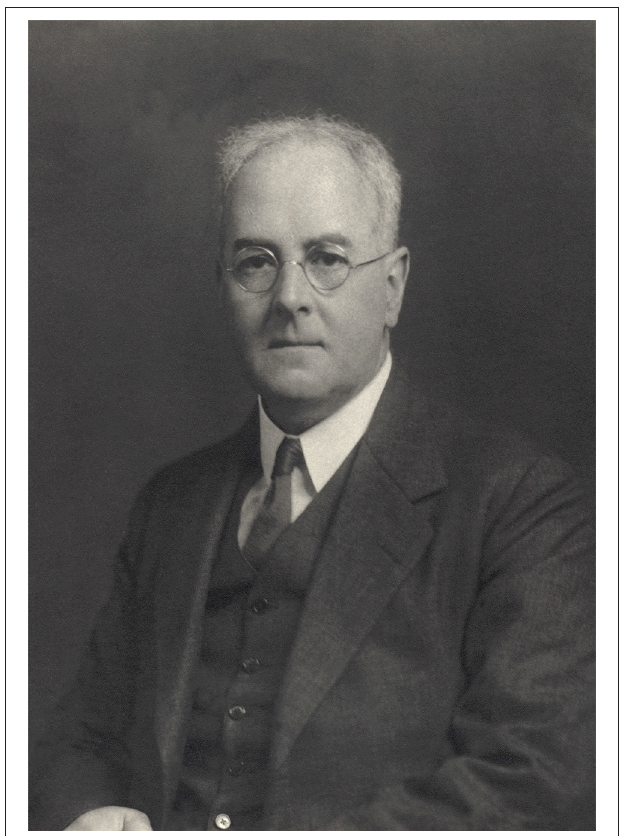
FIGURE 1 | Lewis Fry Richardson (1881–1953), after a photograph taken in 1931 by Walter Stoneman, reproduced with permission from the National Portrait Gallery in